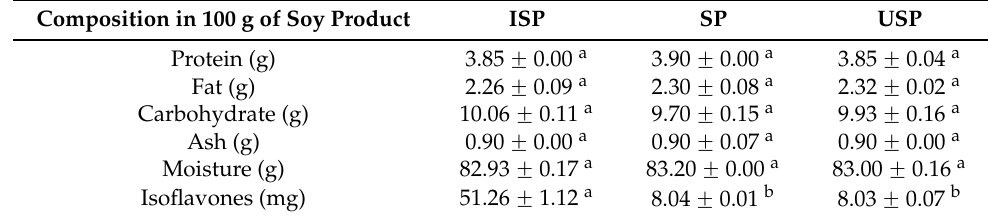
Table 1. Composition of the different soy-based